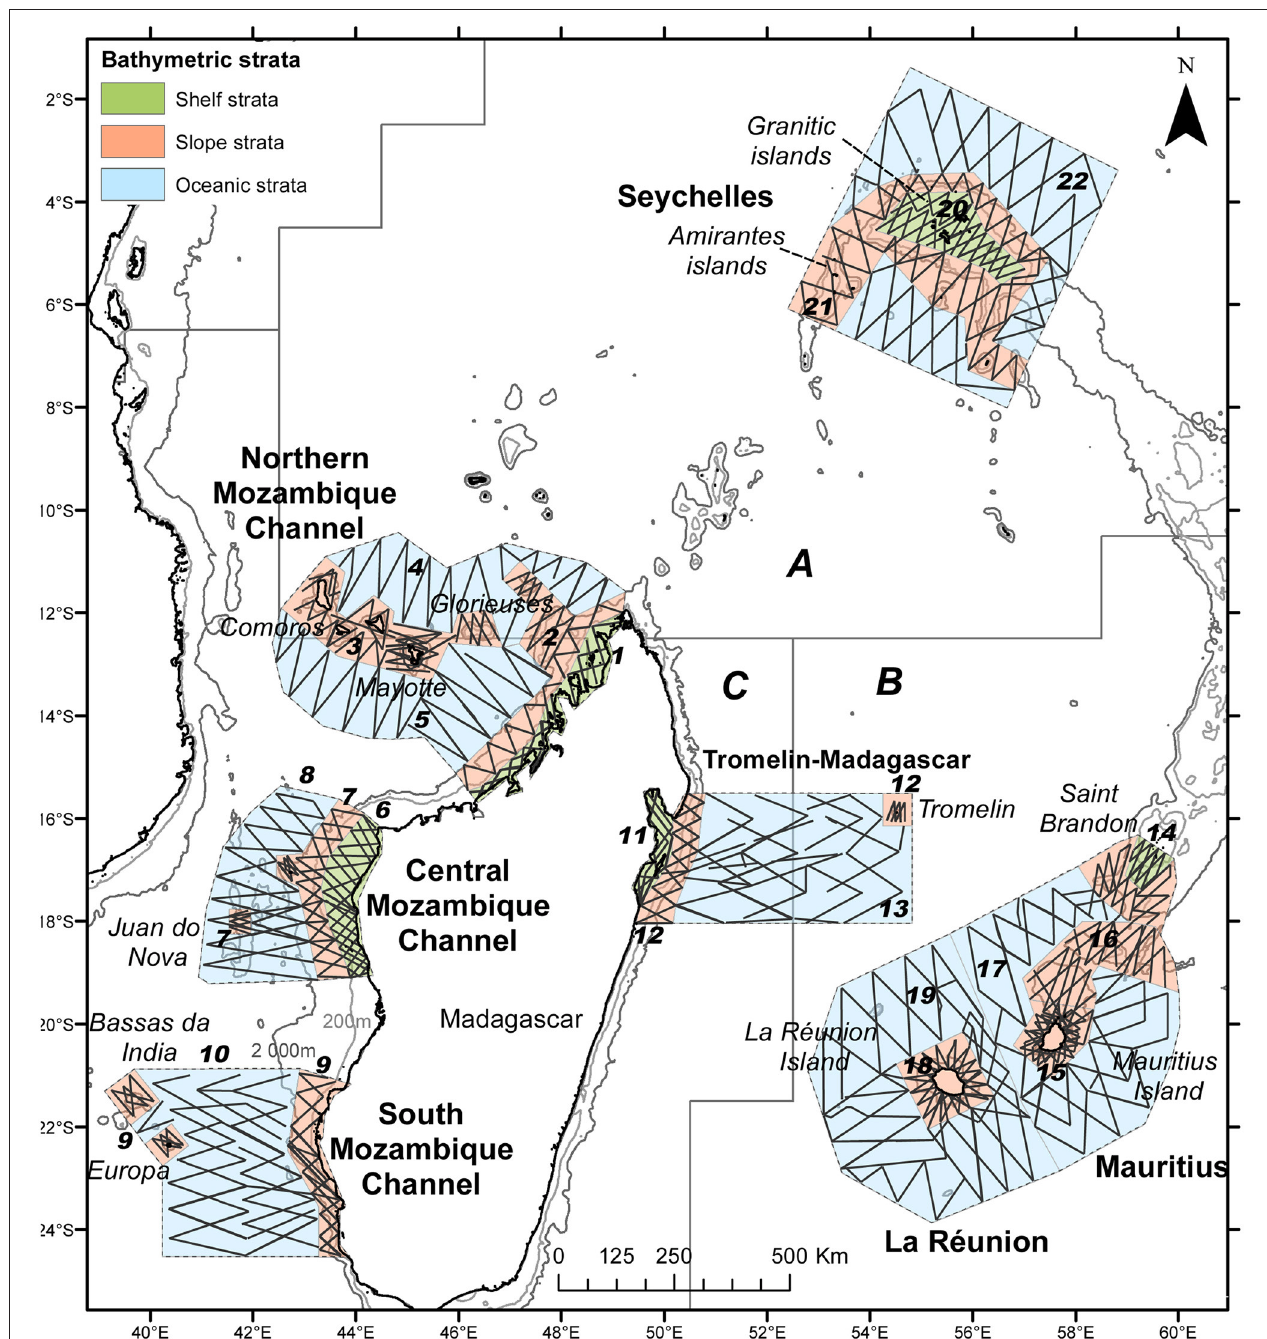
FIGURE 1 | Study area and effort conducted during the REMMOA aerial survey in the SW Indian Ocean. Numbers refer to strata codes used for analysis and letters to the Longhurst Biogeographical Provinces (from http://www.marineregions.org) with A—the Indian Monsoon Gyres Province, B—the Indian South Subtropical Gyre Province, and C—the East Africa Coastal